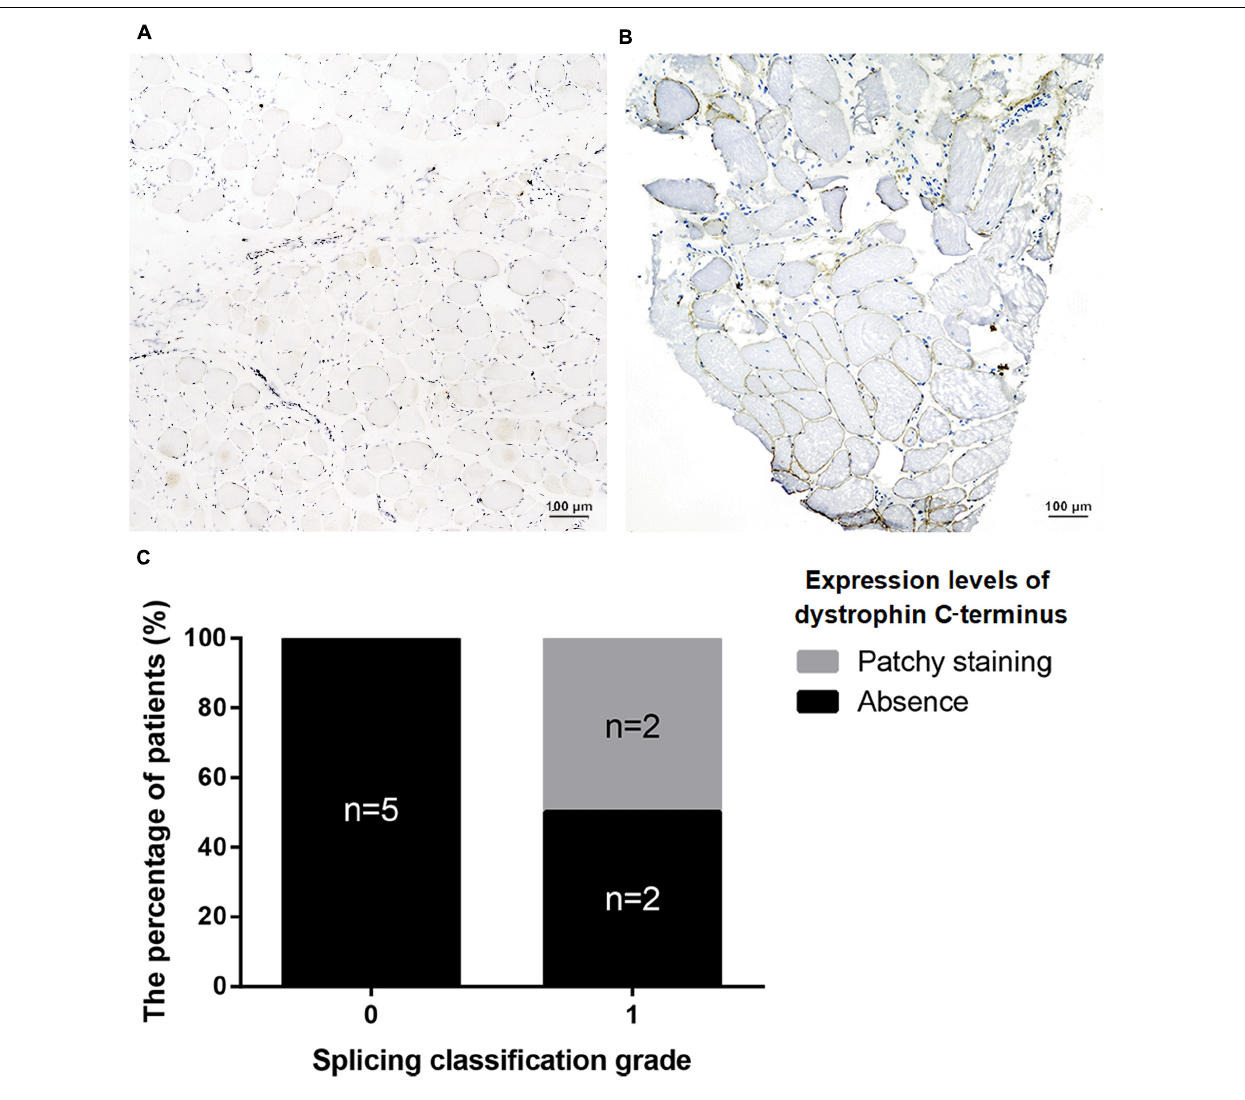
FIGURE 9 | Correlation between splicing classification grades and dystrophin levels in patients with nonsense mutations. Expression levels of dystrophin C-terminus were evaluated using muscle immunohistochemistry with antibody against this terminus. Two staining conditions were observed in the muscle sections: (A) absence staining and, (B) patchy staining. (C) Bar chart representing percentage of patients versus splicing classification